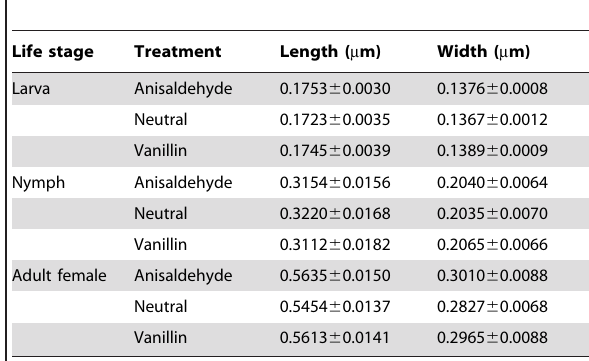
Table 1. Body length and width ( m m; mean 6 SE) of spider mites fed on bean plants ( P. vulgaris ) flavored with vanillin or anisaldehyde or non-flavored